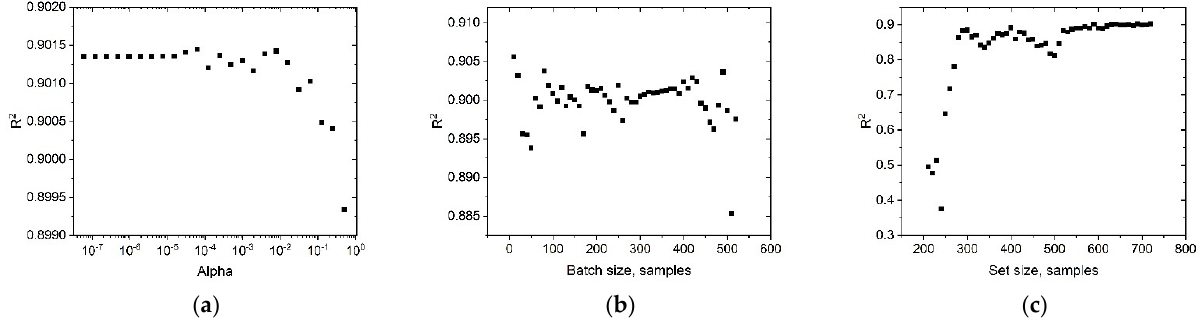
Figure 8. Regularization ( a ) and tuning of the batch size ( b ) and dataset size (number of samples), ( c ).